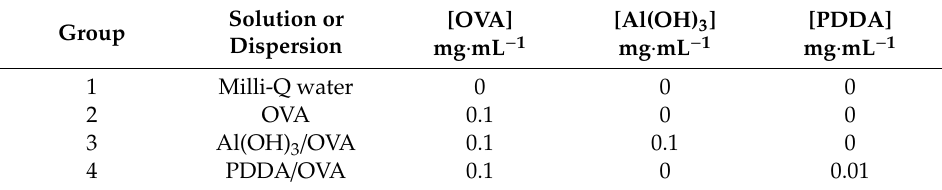
Table 1. Composition of solutions or dispersions in water used for immunization of four groups of five